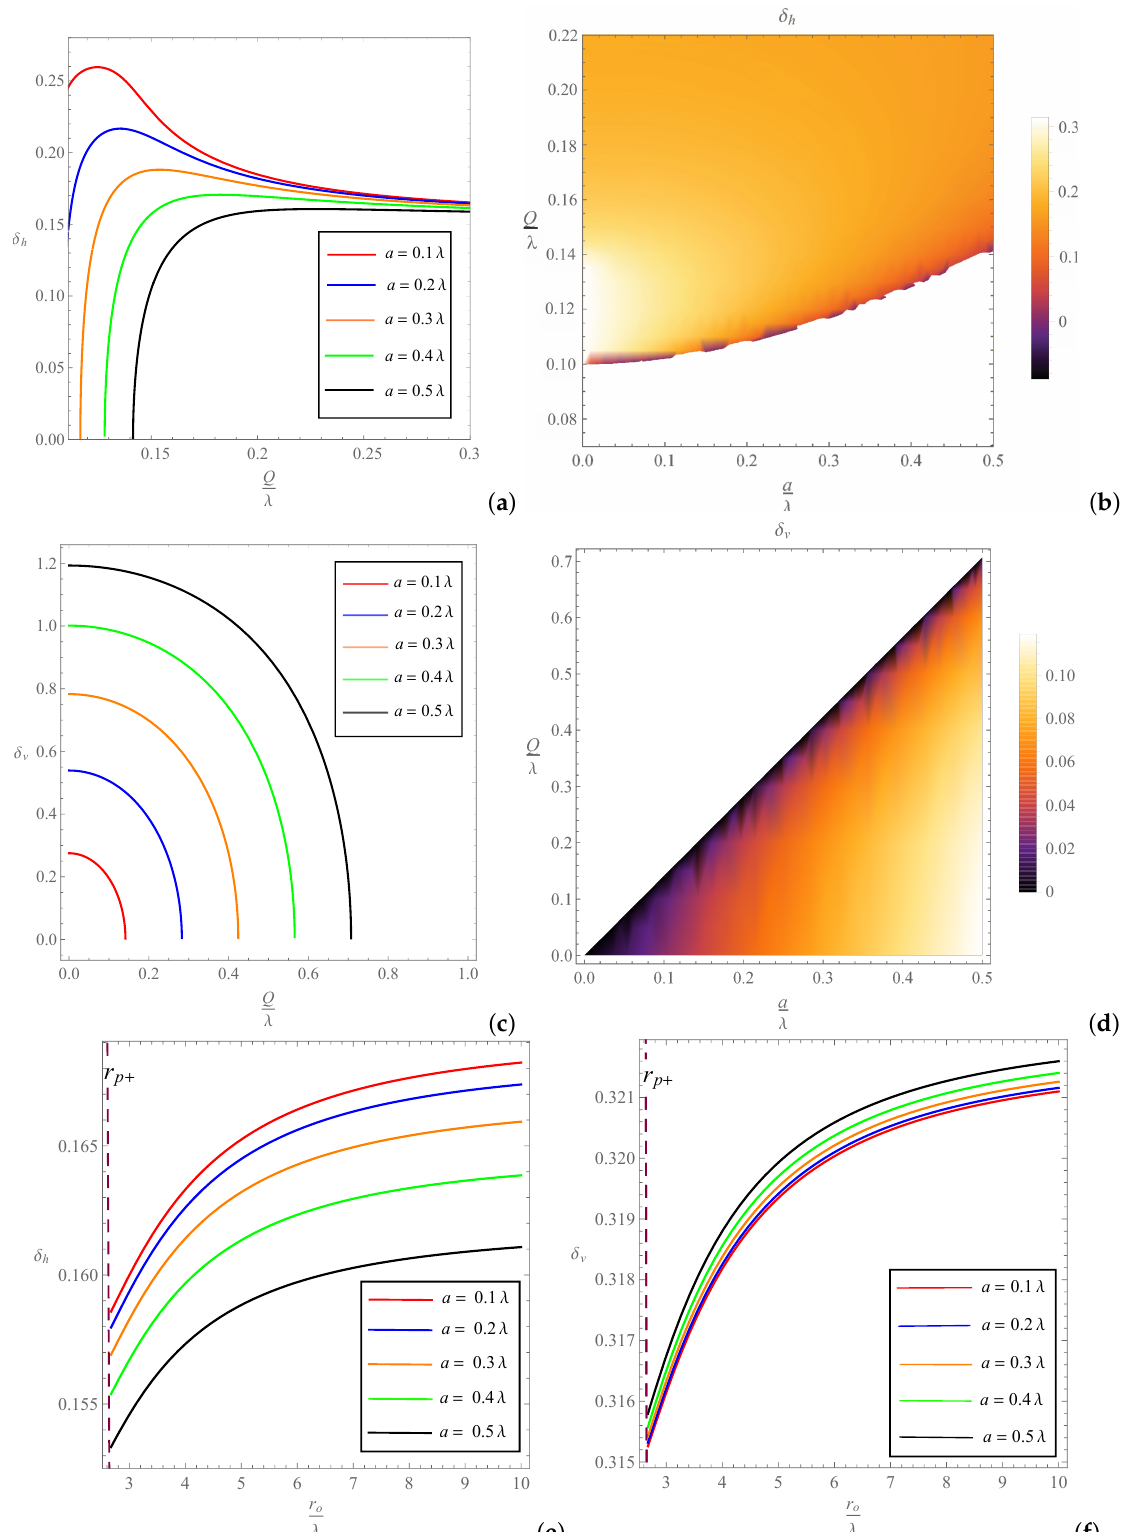
Figure 9. The variations of the horizontal (diagrams ( a , b )) and the vertical (diagrams ( c , d )) angular diameters of the RCWBH as functions of Q and a , plotted for λ = 10 and r o = 5 λ . In the left panels, the changes of angular diameters in terms of Q are plotted distinctly for five values of a . In the right panels, Q and a can change freely. The bottom panel diagrams (( e , f )), correspond to the dependence of the angular diameters on the variations of the observer’s location r o , which are plotted for Q = 0.3 λ